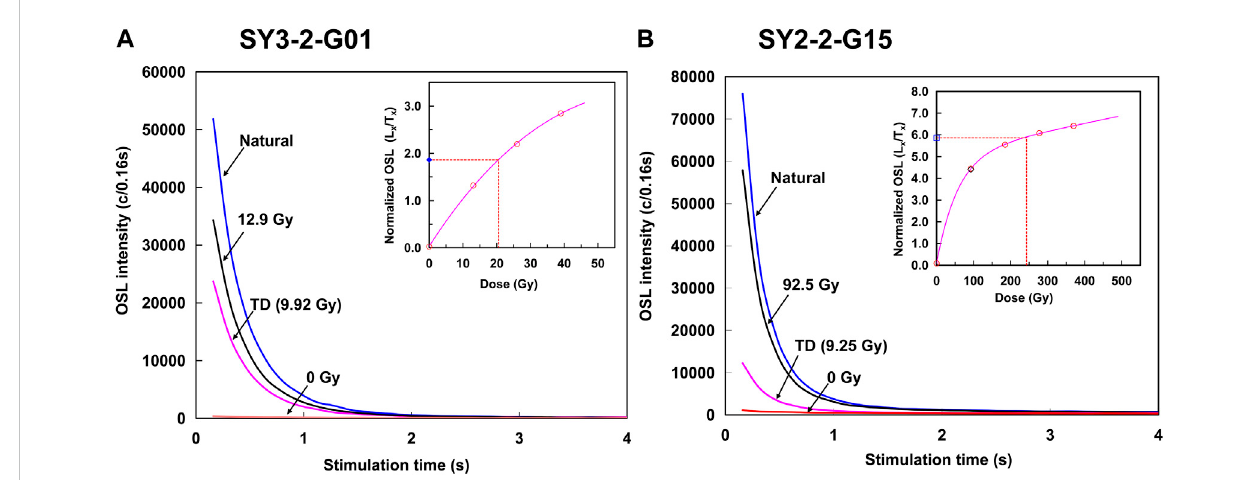
FIGURE 3 OSL decay and growth curves of samples (A) SY3-2-G01 and (B) SY2-2-G15 in the neritic area of the Lianjiang River